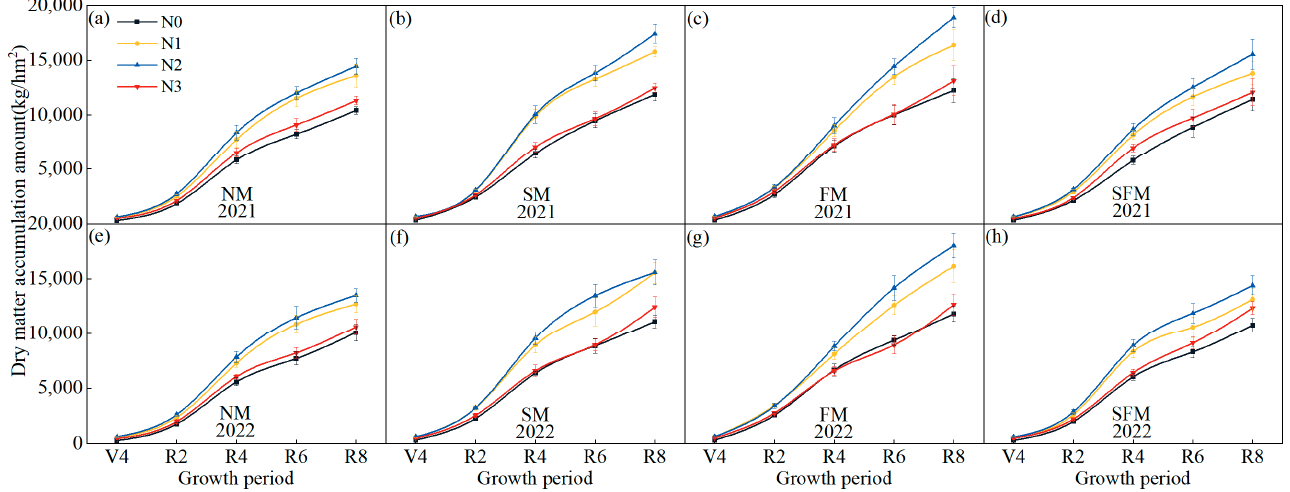
Figure 4. The effects of nitrogen application and mulching treatments (NM, SM, FM, SFM) on soy‑ bean above‑ground biomass at different growth stages in 2021 and 2022 ( a – h ). Vertical bars indicate the LSD values at p = 0.05 level.